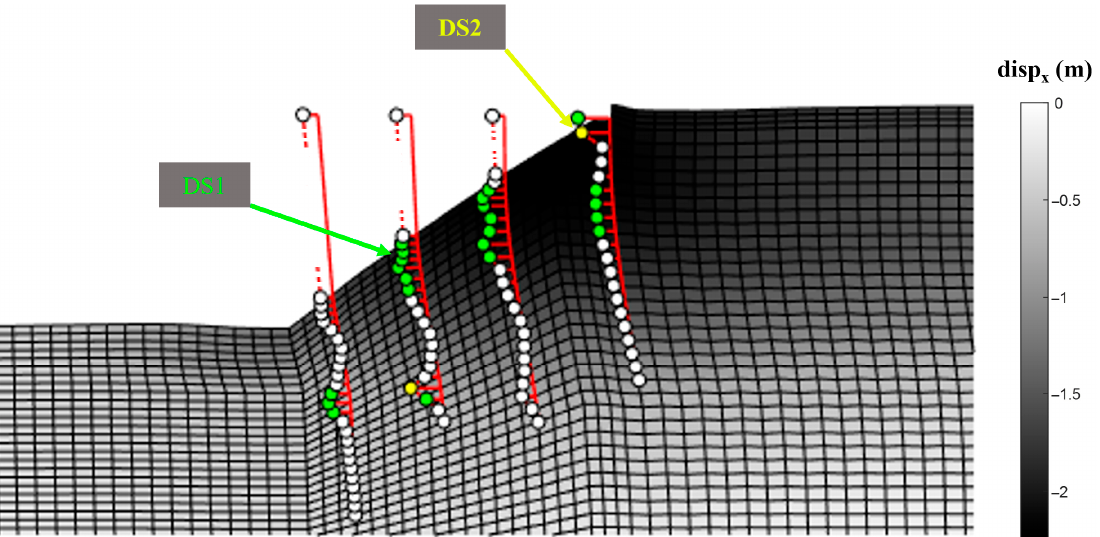
Figure 7. Close ‐ up view of end ‐ of ‐ motion displacement pattern with peak absolute curvature de ‐ Figure 7. Close-up view of end-of-motion displacement pattern with absolute curvature demands on mands on the piles (shown only for the embedded part). the piles (shown only for the embedded